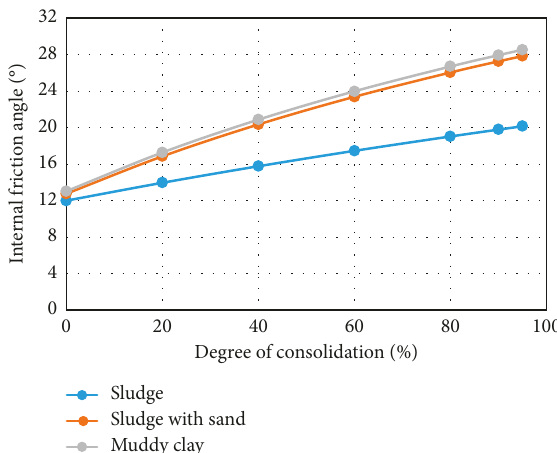
Figure 3: Relationship curve of internal friction angle and degree of consolidation.